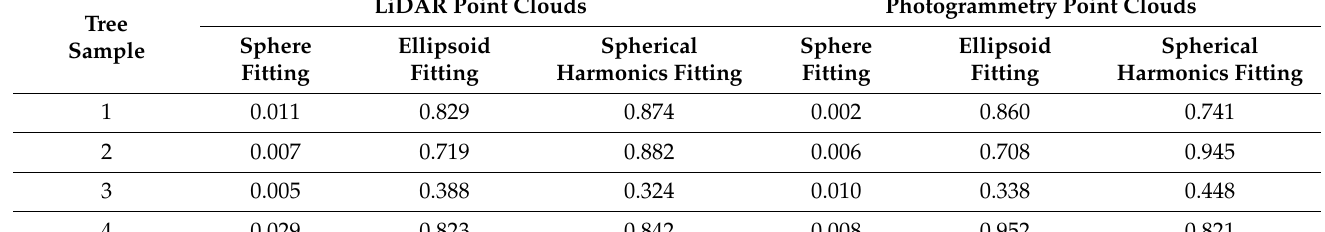
Table 3. R 2 of each fitting method.